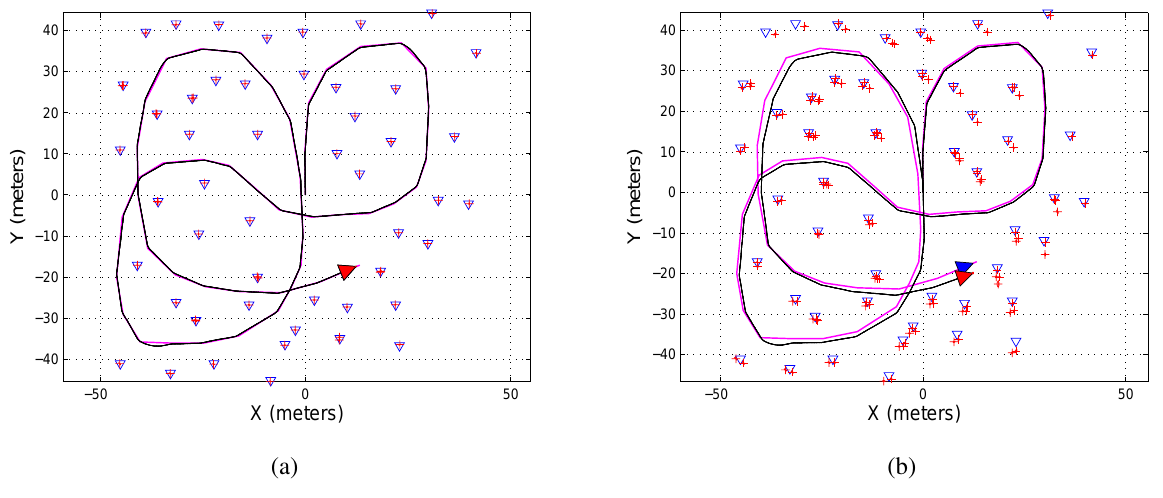
Figure 7. Map reconstruction of the environment using the sum of eigenvalues feature selection criterion on the EKF-SLAM. (a) Shows the map reconstruction when the five most significant features— LIM = 5 in Algorithm 4—were used for the correction stage of the EKF-SLAM; (b) shows the map reconstruction when LIM = 2 . The path traveled by the mobile robot is represented in a solid black line and the path estimated by the SLAM in solid magenta; the features are represented by blue triangles and the ellipses of uncertainty associated with each feature are in solid